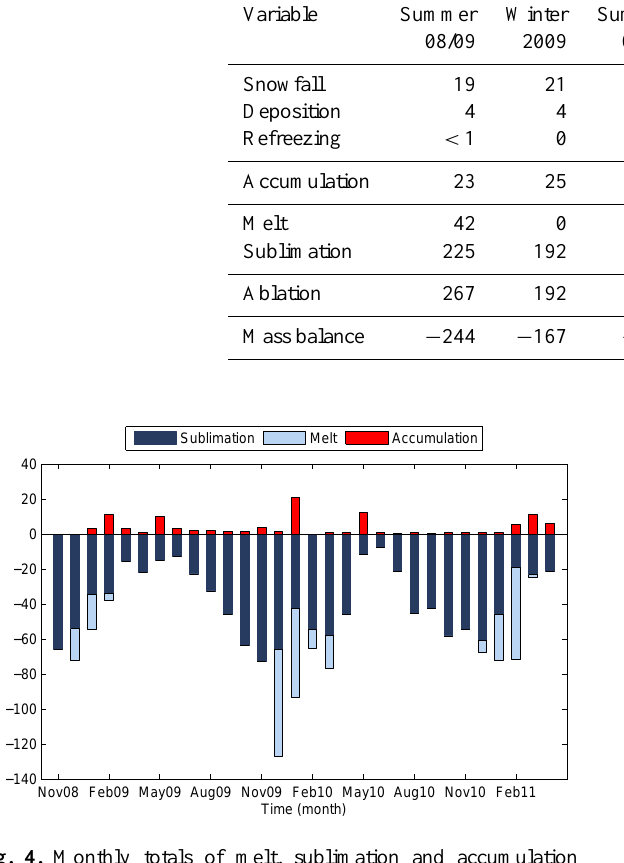
Fig. 5. Monthly averages of the modelled heat fluxes at the Guanaco Glacier surface for the period 9 October 2008–30 April 2011. (Note: SW ∗ is net shortwave radiation, LW ∗ is net longwave radiation, QS is the sensible heat flux, QL is the latent heat flux, QG is the subsurface heat flux, and QM is the energy consumed by melt).